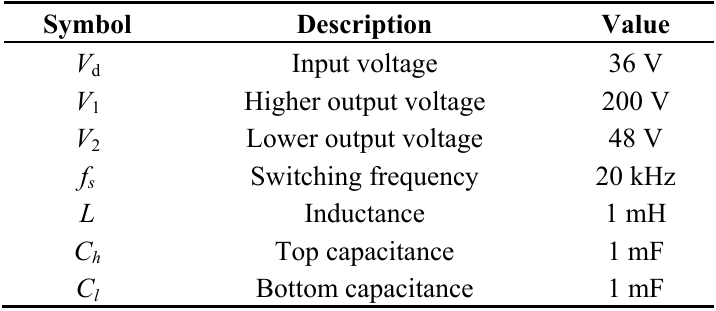
Table 1. Nominal setting value for numerical analysis.